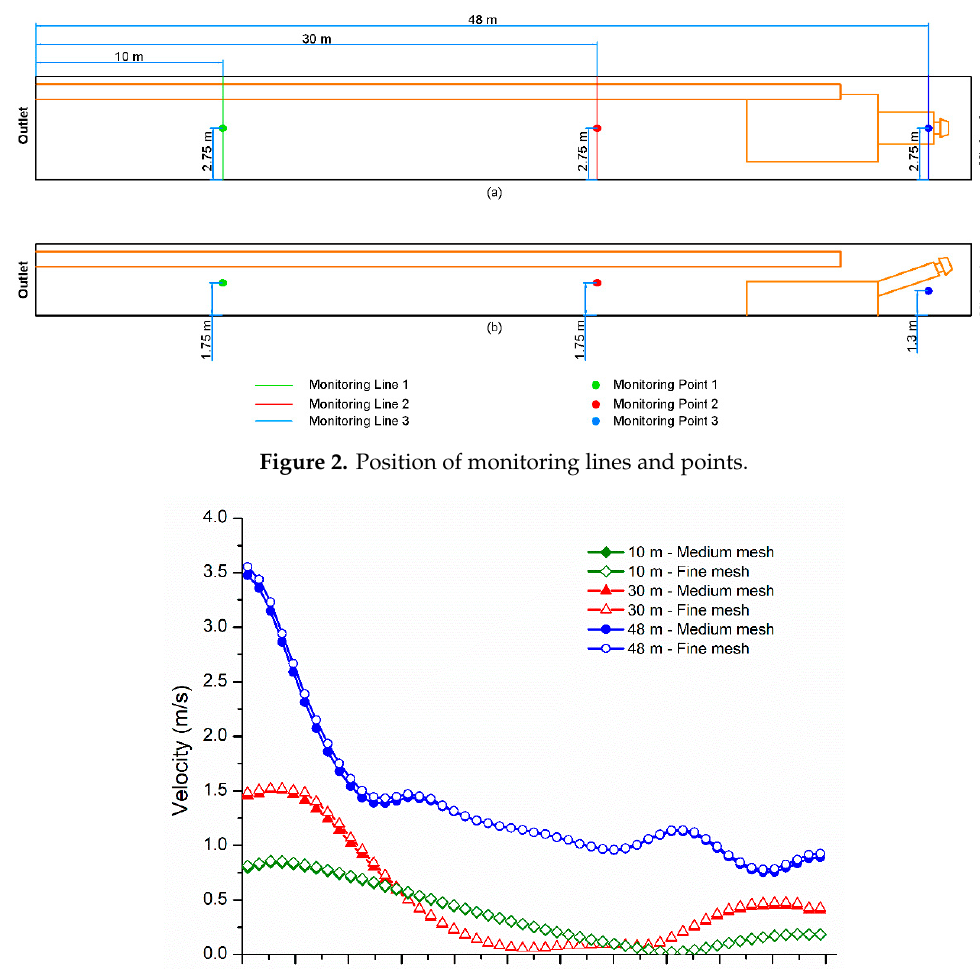
Figure 3. Airflow velocities at monitoring lines.